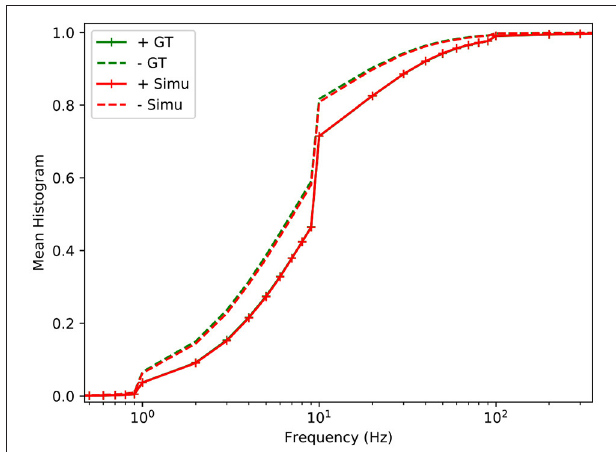
FIGURE 7 | Cumulative distribution function of the relative spectrum of the ATIS (Posch et al., 2011) positive and negative background noise (irradiance 0.1 lux), for real data (green) and simulated